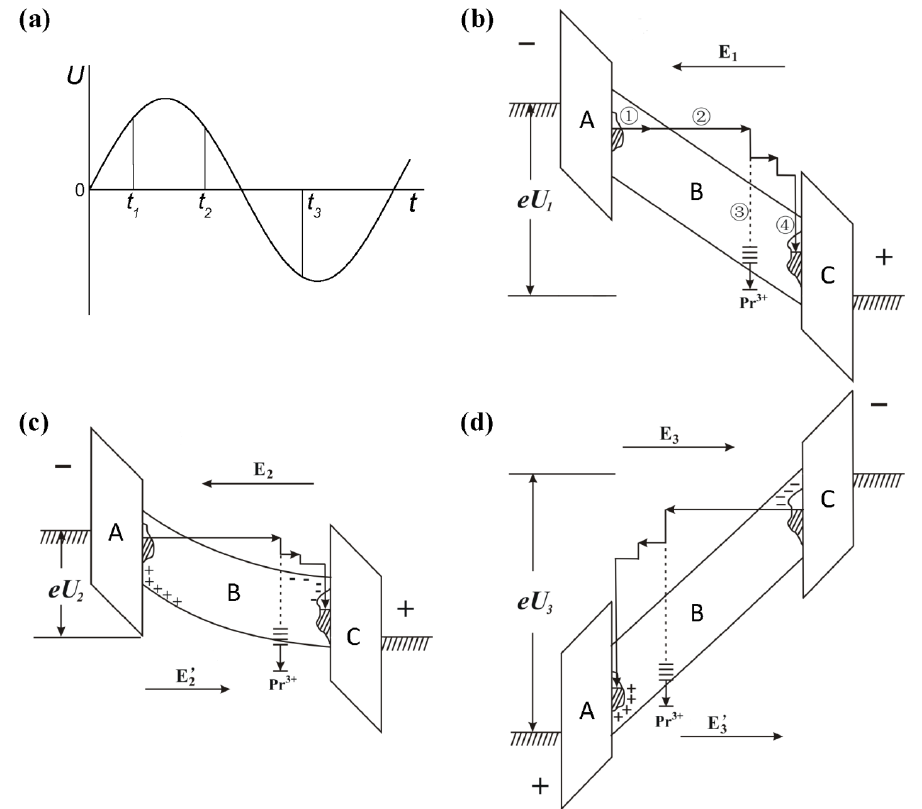
Figure 5. Schematic illustration of the proposed AC electroluminescent processes in (Ba 0.4 Ca 0.6 )TiO 3 :Pr 3+ diphase polycrystals with a sandwich structure. A and C: Ba 0.77 Ca 0.23 TiO 3 :Pr 3+ dielectric grains; B: Ba 0.1 Ca 0.9 TiO 3 :Pr 3+ phosphor grain. (a) Three representative moments ( t 1 , t 2 , t 3 ) in a cycle of AC electric field, (b) – (d) electroluminescent processes corresponding to t 1 , t 2 , t 3 moments, respectively. ①: